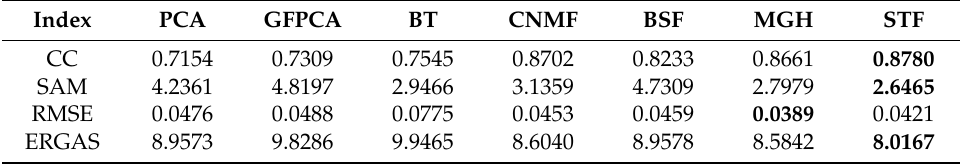
Table 5. Quantitative results of different fusion methods for Hyperion dataset.